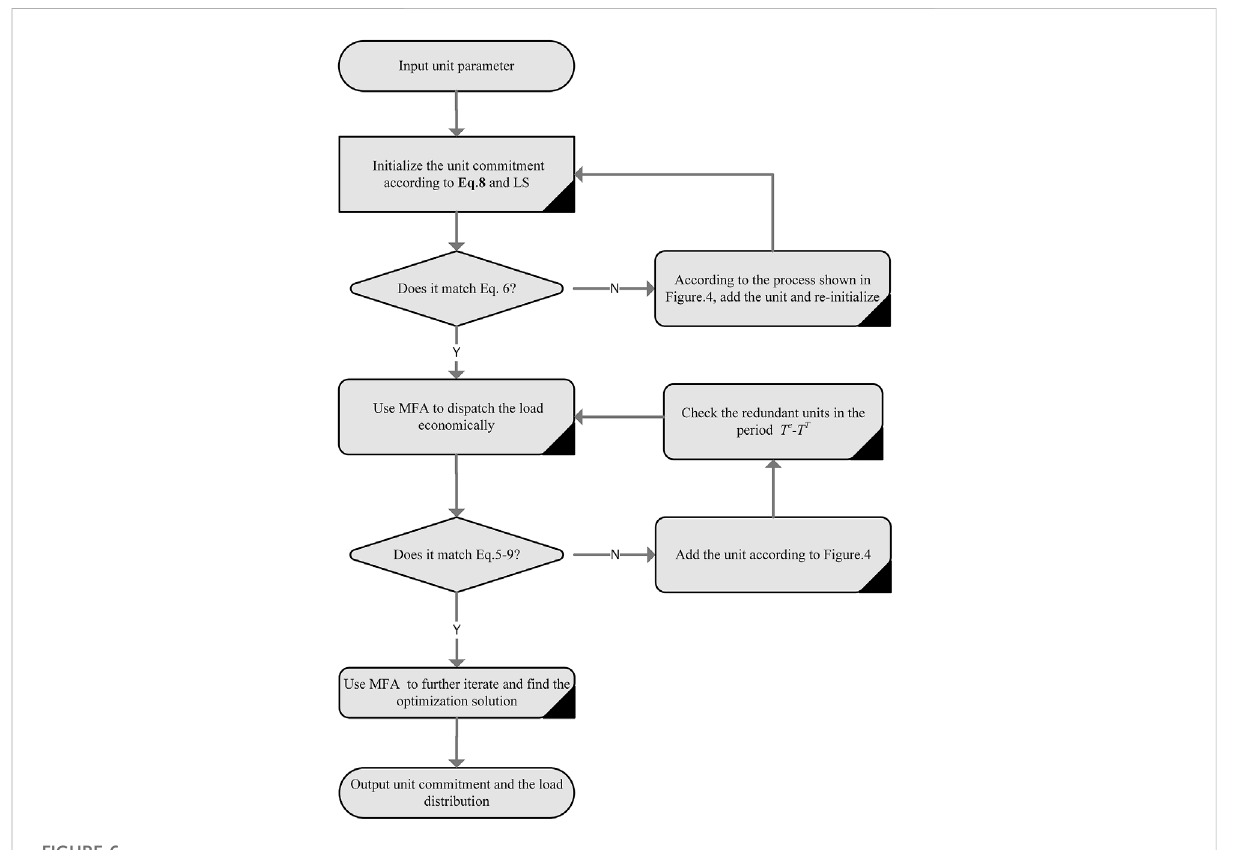
FIGURE 6 Overall fl ow chart for solving unit commitment problem.